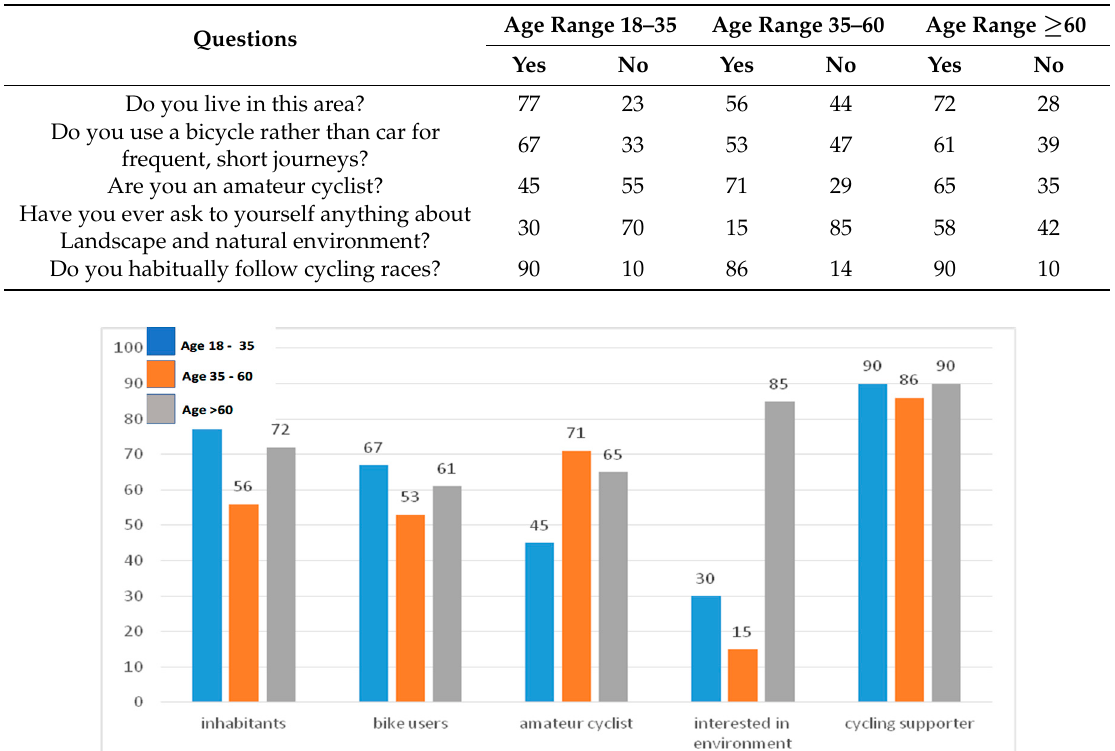
Table 1. Table of personal involvement in cycling and environment.